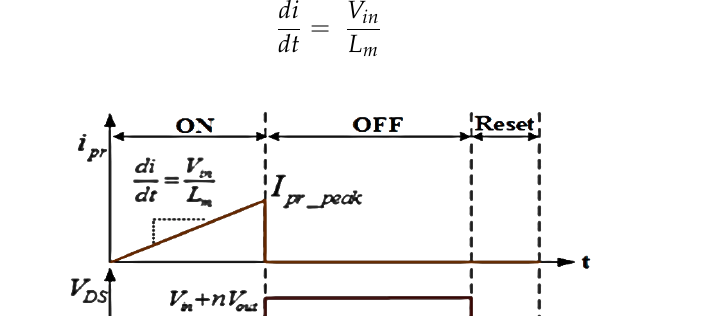
Figure 6. Key waveforms of DCM control of Li-ion battery discharging.